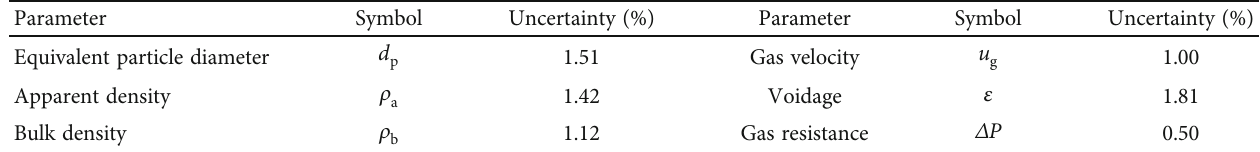
Table 5: Summary of the relative uncertainty of parameters in this